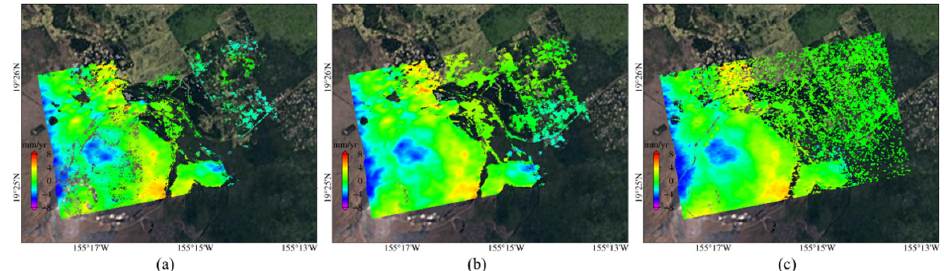
Figure 14. Deformation velocity maps obtained using ( a ) Single-pol method, ( b ) PolHom test method, and ( c ) PIHP method.